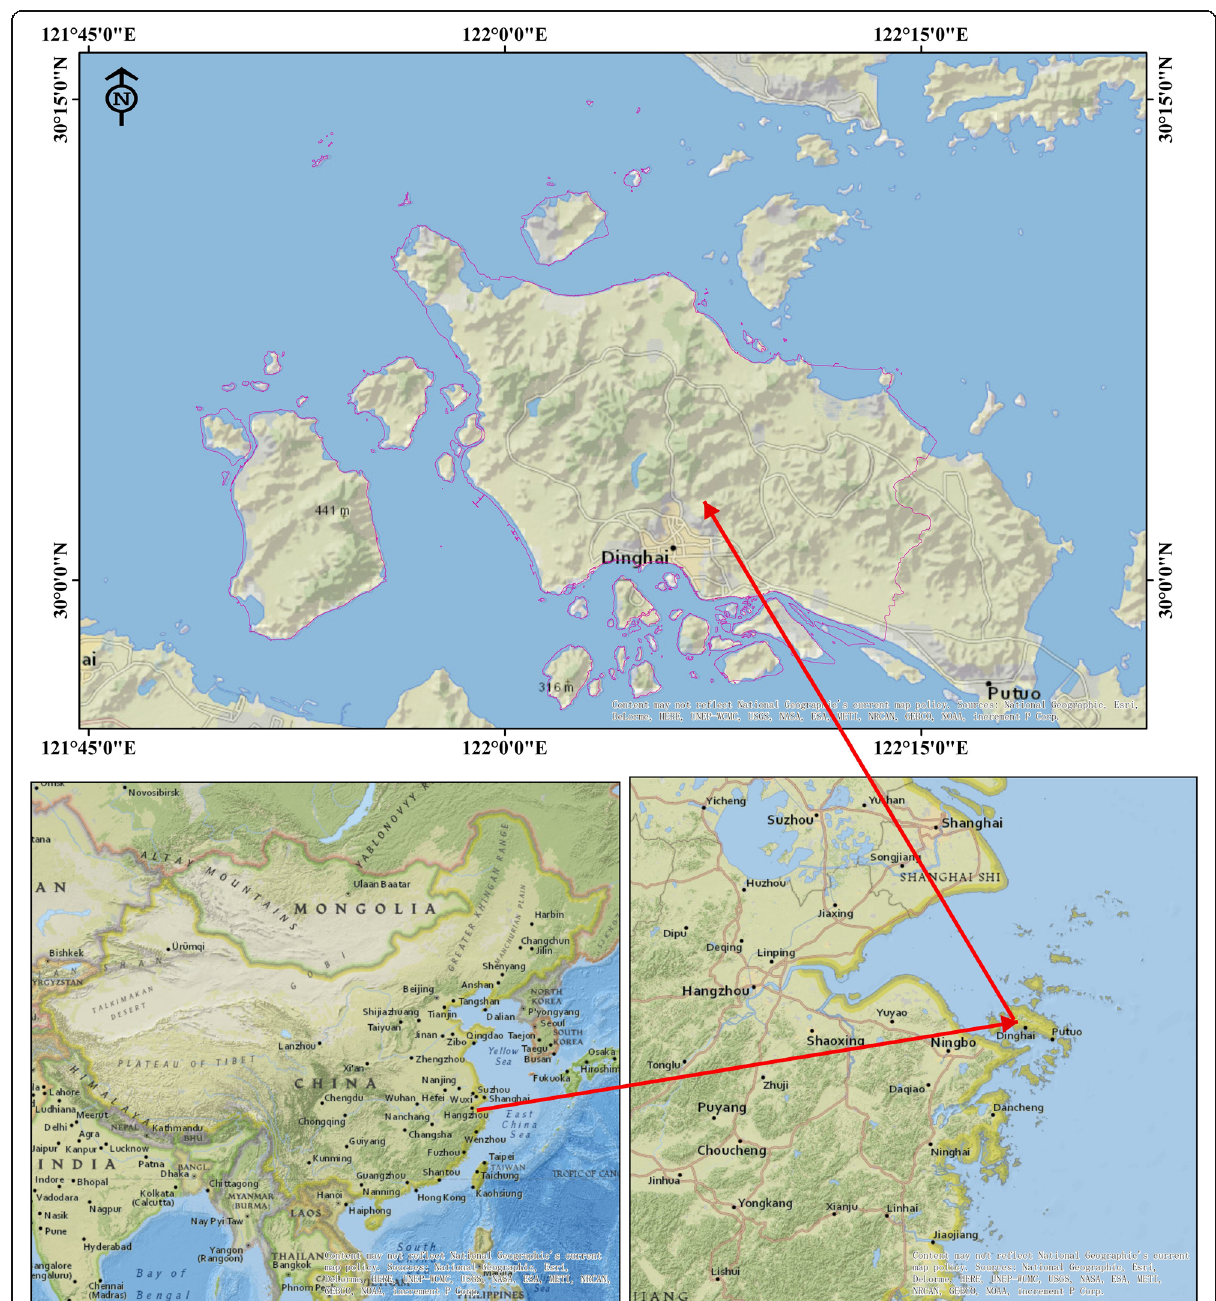
Fig. 1 The study area of Dinghai District in the Zhoushan Archipelago, Zhejiang Province, China